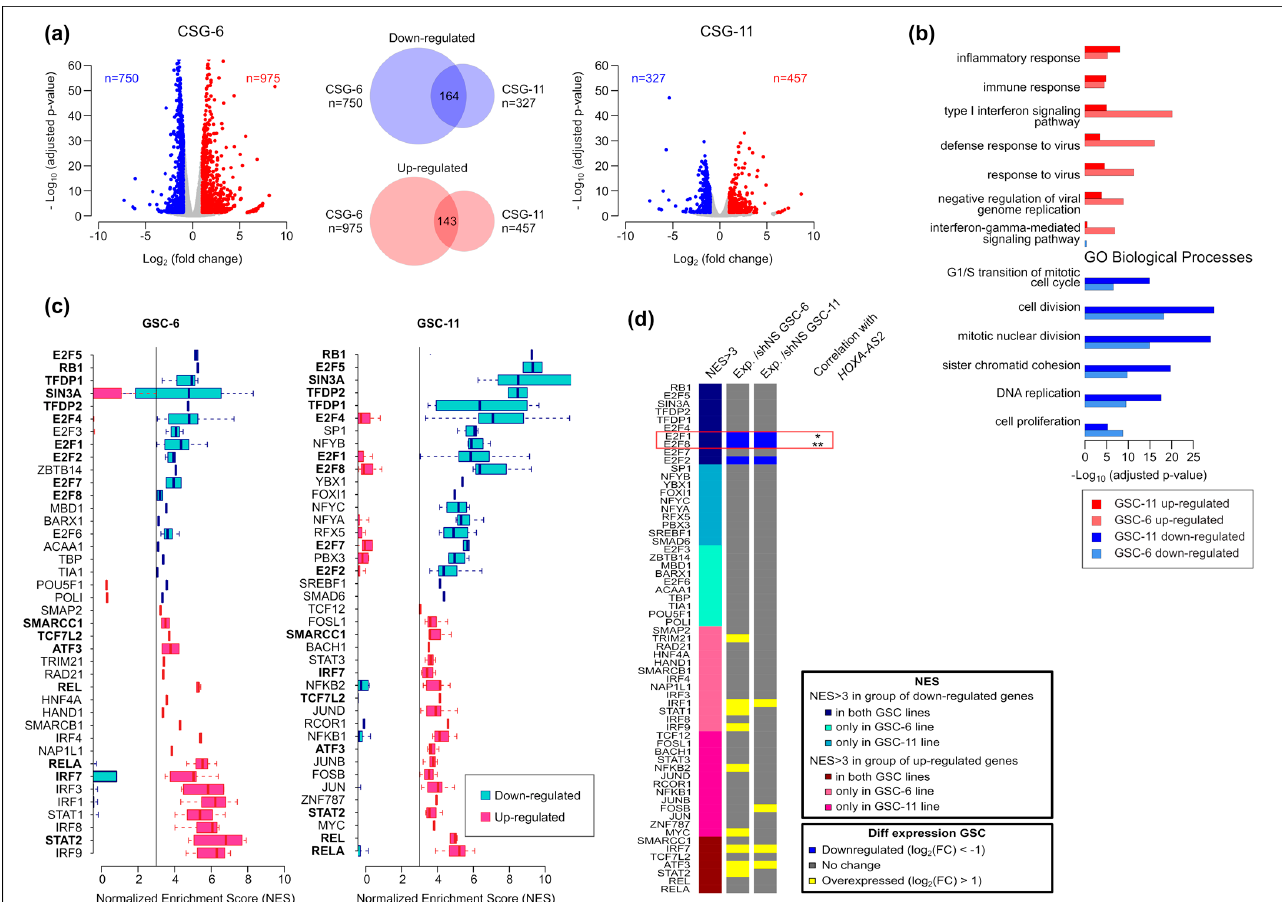
Figure 5. Identification of HOXA-AS putative direct targets in GSCs. ( a ) Volcano plots analysis of differential gene expression following HOXA-AS2 silencing in GSG-6 (left) and GSC-11 cells (right). Blue and red dots represent genes that were significantly down- or upregulated, respectively. Venn diagrams (middle) showing the overlapping between downregulated (blue) and upregulated (red) genes. ( b ) Gene Ontology terms (biological processes) enriched in downregulated (in blue) and upregulated (in red) genes in GSC-11 and GSS-6 cells following HOXA-AS2 silencing . The five highest terms of each category, in each GSC line, are shown. ( c ) Transcription factor motif enrichment at the promoter (defined as the area covering -1 kbp of RefSeq TSS) of up- and downregulated genes following HOXA-AS2 silencing in GSG-6 and GSC-11 cells, calculated using i-cis Target and represented as normalized enrichment score (NES). Transcription factors with motif enrichment in both cell lines are in bold. When a transcription factor harbors several binding motifs, data are presented as a box plot. Only the top 20 transcription factors with NES >3 are shown. ( d ) Expression changes, assessed using publicly available RNA-seq data from 134 IDHwt glioma samples (TCGA cohort), of the transcription factors identified in ( c ) and that were deregulated or upon HOXA-AS2 silencing compared with control (shNS) in GSC-6 and -11 cells (blue, downregulated: log2(Fold Change) < − 1; gray, no change; yellow, overexpressed: log2(Fold Change) > 1). Significant correlation with HOXA-AS2 expression, assessed for the 13 up- or downregulated transcription factors, is indicated in the right column. * p < 0.05, ** p < 0.01 (Mann-Whitney U -test).